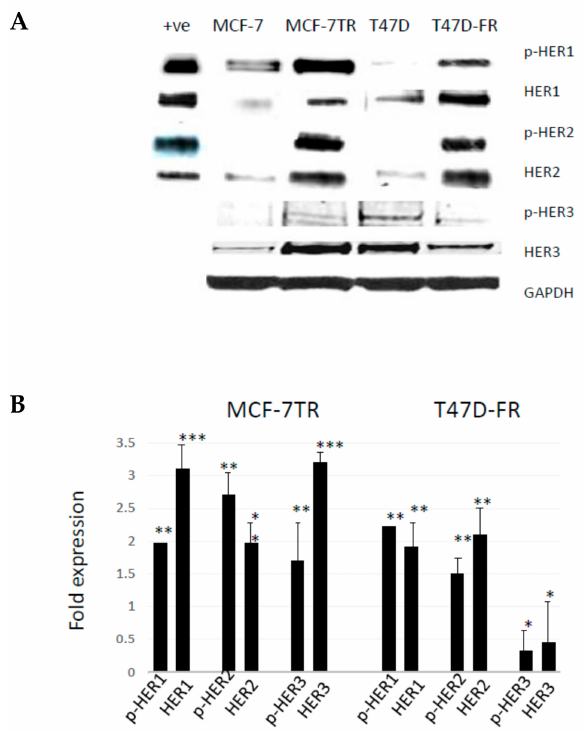
Figure 2. Levels of HER expression in breast cancer cell lines with acquired resistance to anti-oestrogen therapy. Representative Western blot data obtained from whole-cell lysates ( A ) separated by SDS-PAGE and immunoblotted onto PVDF membranes before immunodetection ( n = 4). The head and neck cancer HN5 cell line HER1 + ve and breast cancer SKBR3 cell line HER2 + ve were used as positive controls. ( B ) Expression levels of parental cells (set at 1.0) were compared with the resistant variant using the following paired t -test levels of statistical significance for densitometric scans: * p < 0.05; ** p < 0.001; *** p <